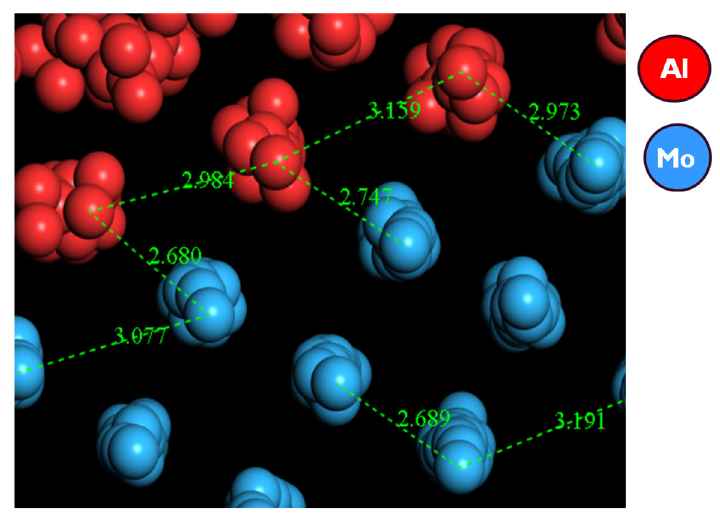
Figure 9. The predicted atomic distances of solid Mo in contact with molten Al.